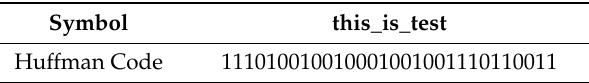
Table 3. Huffman codes of ‘this_is_test’ text.